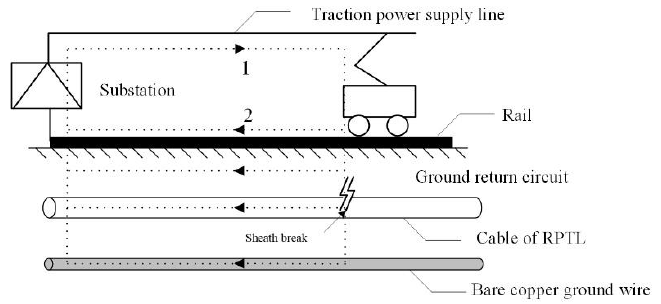
Figure 6. Schematic diagram of power supply return for high speed railway.